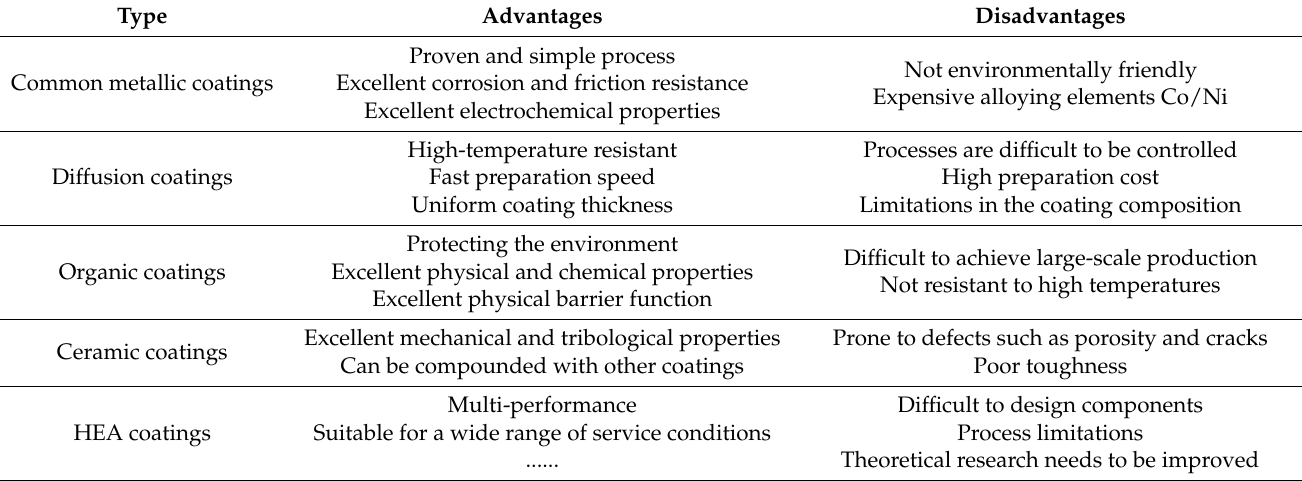
Table 1. Comparison of different types of